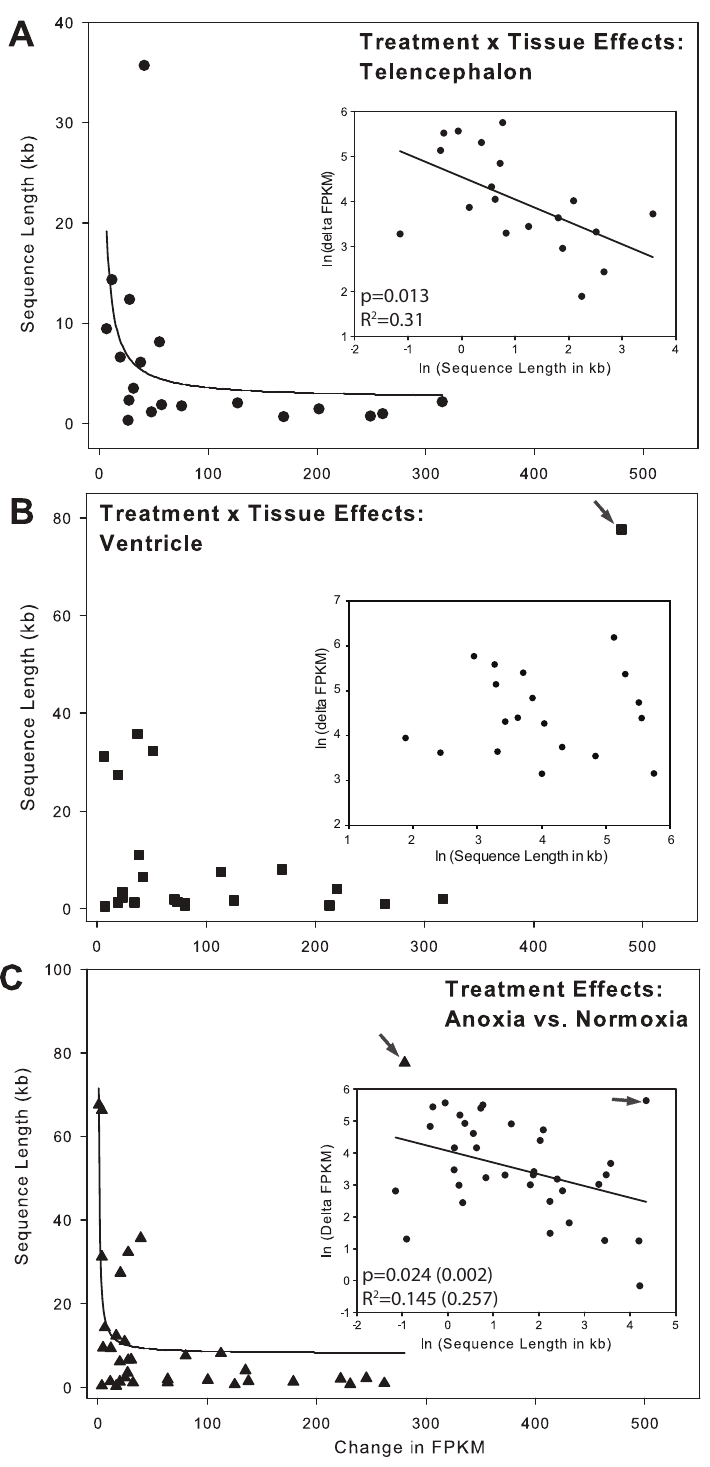
Fig 5. Sequence length as a predictor of increased gene abundance. (A) In telencephalon, longer genes show smaller changes in FPKM. The inset shows the linear regression analysis comparing the ln (delta FPKM) vs. ln (sequence length). (B) In ventricle, there is no significant relationship between delta FPKM and sequence length (regression not shown). The arrow indicates the expression value and sequence length of a GLUT isoform (Slc2a1,3,14). Excluding that point did not decrease the P-value appreciably. (C) When